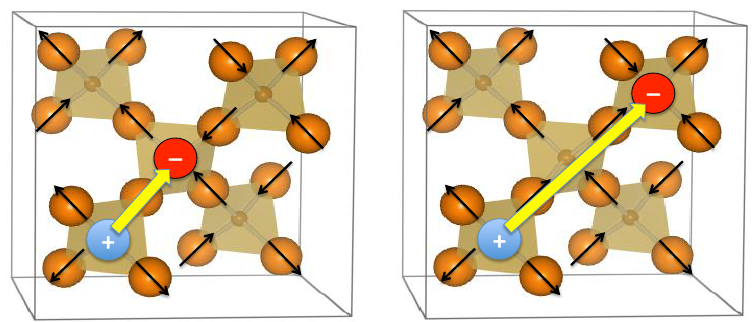
Figure 5. (color online) The creation and propagation of magnetic monopoles in dipolar spin ice. The 3-out, 1-in state is a source of magnetic flux (positive charge), and the 3-in, 1-out state is a sink of magnetic flux (negative charge).